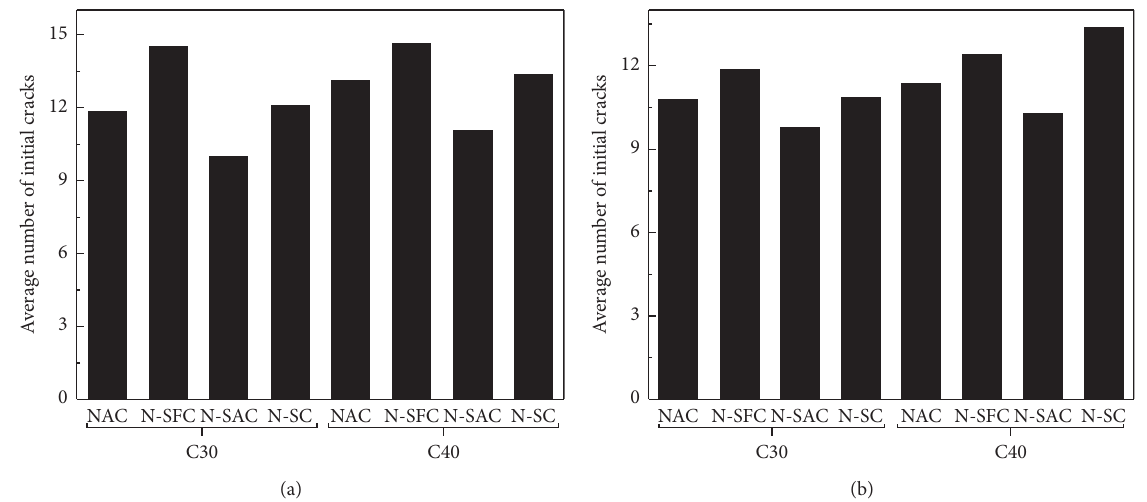
Figure 11: Comparison of impact resistance times of coal gangue concrete. (a) Initial cracking. (b) Final